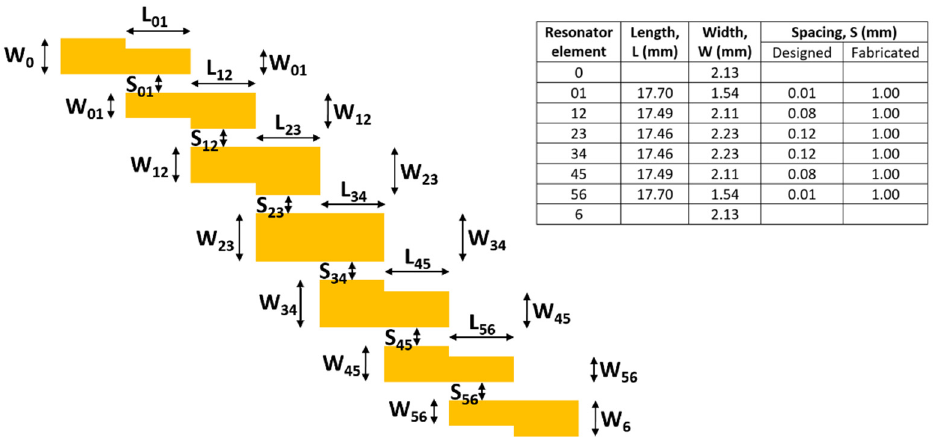
Figure 1. Schematic for the design of the 5th-order microstrip band-pass filter. Geometric parameters for a filter with a 2.5 GHz central frequency are given in the adjacent table.